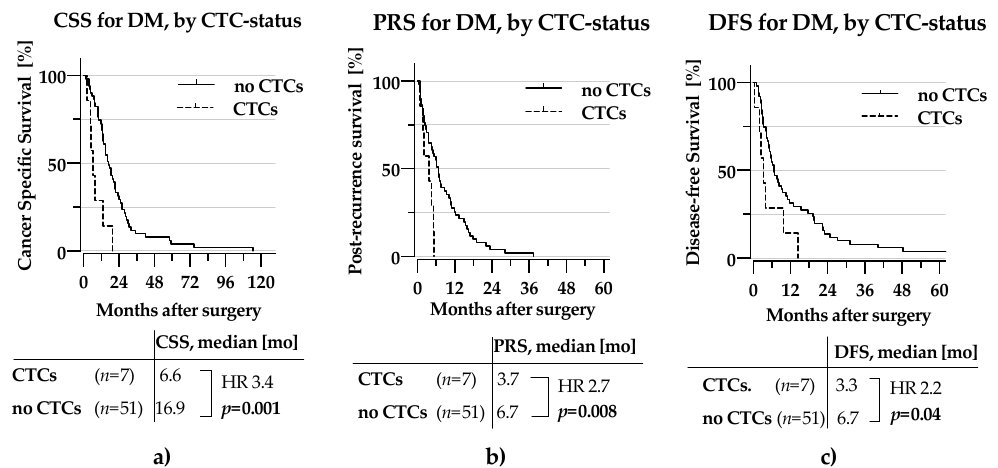
Figure 4. KM-curves for patients with DM as site of first metastasis ( a ) CSS by CTC-status ( b ) PRS by CTC-status ( c ) DFS by CTC-status CTC : Circulating tumour cell, CSS : Cancer-specific survival, PRS: Post-recurrence survival, DFS: Disease-free survival, HR: Hazard ratio. Statistical significance assumed for p < 0.05, indicated by use of bold font.